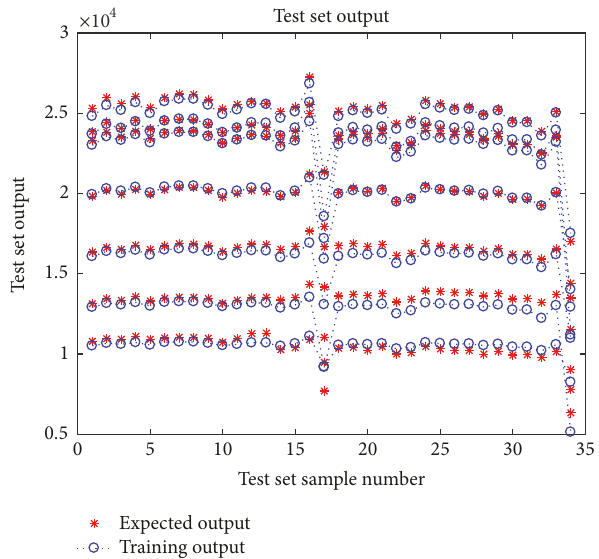
Figure 6: Prediction results of DBN based rolling force prediction model.